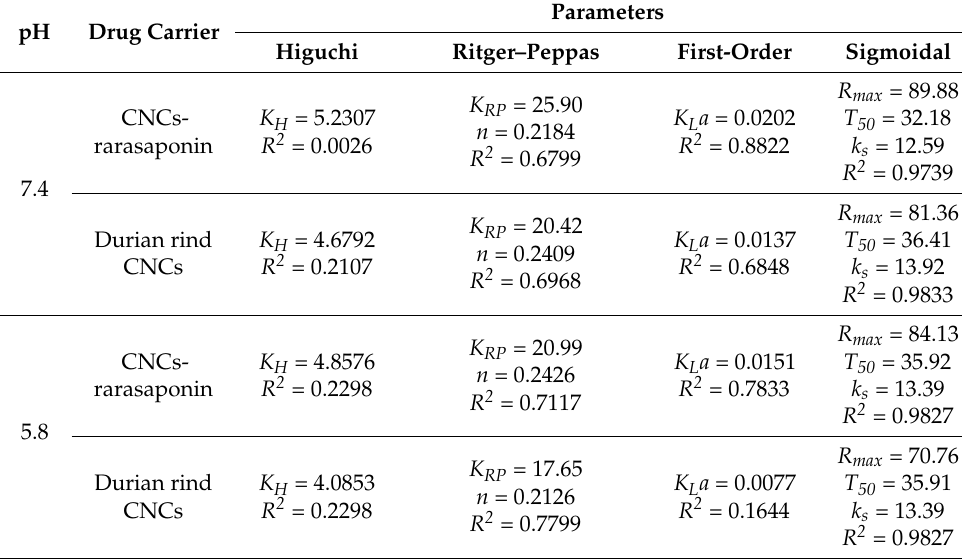
Figure 7. Dexamethasone released from durian rind CNCs at 37 °C. Table 1. Parameters of several released kinetic